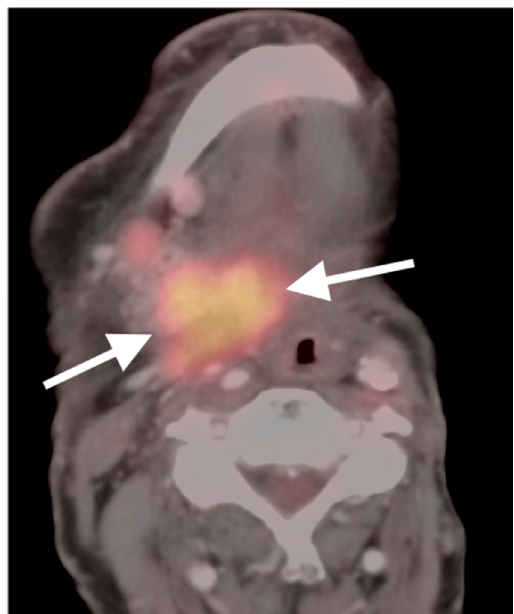
Figure 7. Trans ‐ spatial recurrent tumor on FDG PET ‐ CT (white arrows) in a patient who has under ‐ Figure 7. Trans-spatial recurrent tumor on FDG PET-CT (white arrows) in a patient who has under- gone prior laryngectomy and left radical neck dissection. gone prior laryngectomy and left radical neck